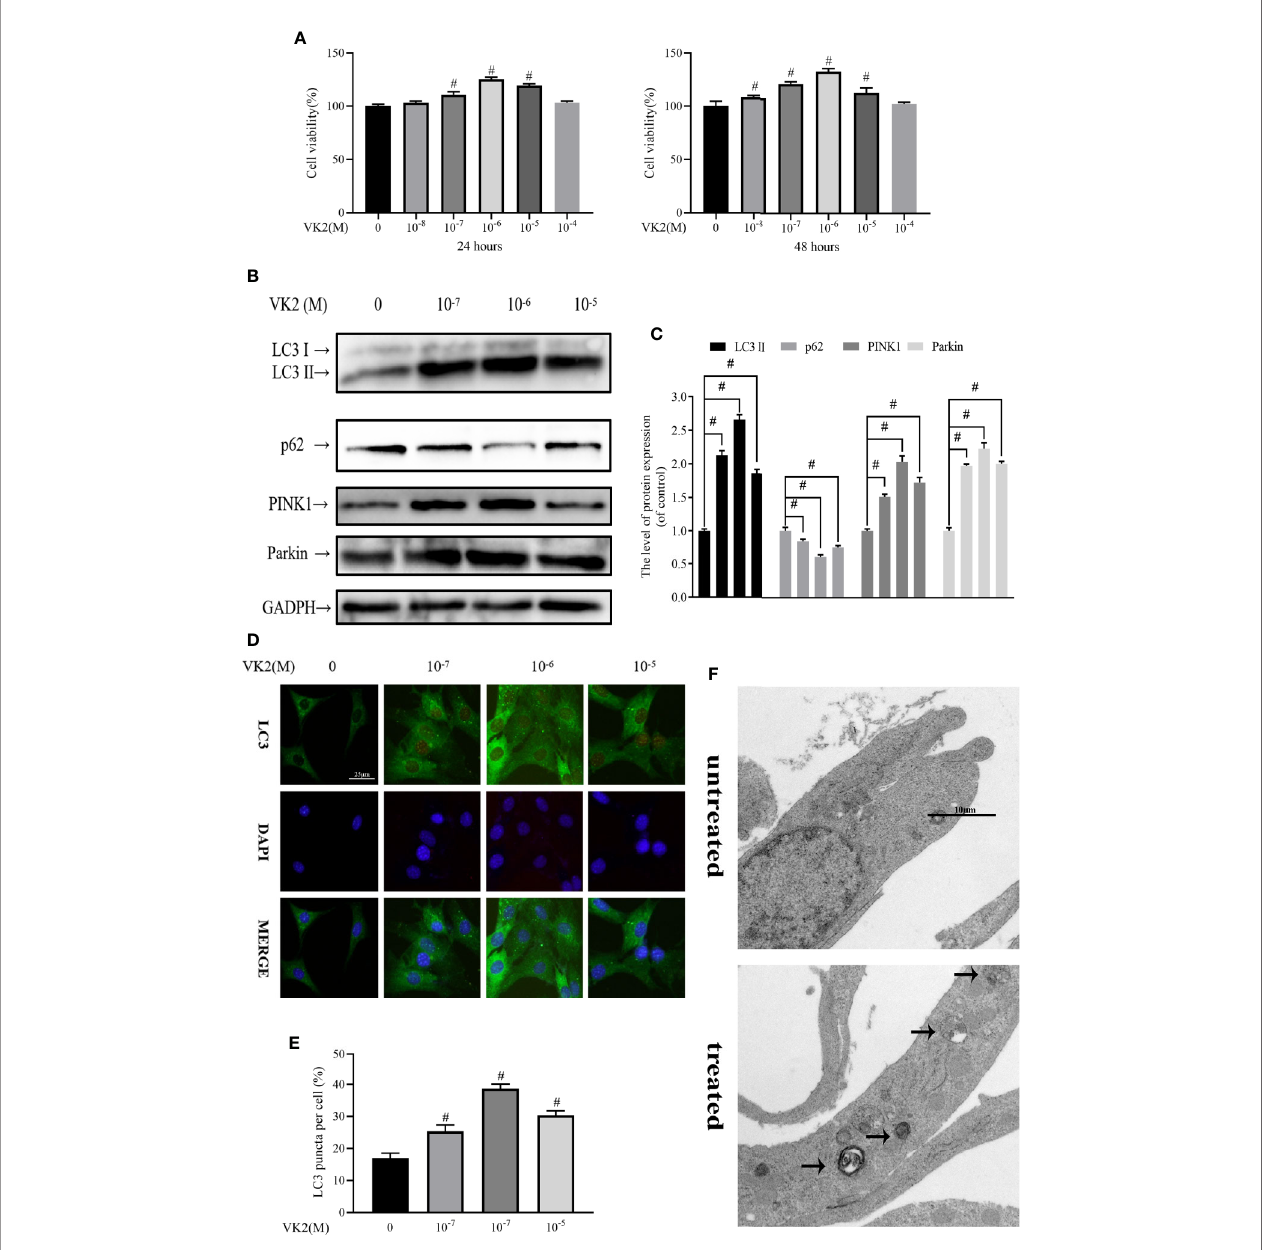
FIGURE 2 | Vitamin K2 (VK2) activates both autophagy and mitophagy in osteoblasts. (A) Effects of different concentrations of Vitamin K2 on the growth of osteoblasts after being treated for 24 h or 48 h, as measured by CCK8 assays; (B) Western blot results showed the change of mitophagy-related protein expression; (C) Analysis of the western blotting results in (B) ; (D, E) Representative images and quanti fi ed analysis of immuno fl uorescence staining of LC3 in osteoblasts; (F) Mitophagosomes were detected by transmission electron microscopy (×10000) in osteoblasts. (Black arrow: mitophagosome). Data was expressed as mean ± SEM, n = 5; # p < 0.01 vs. control